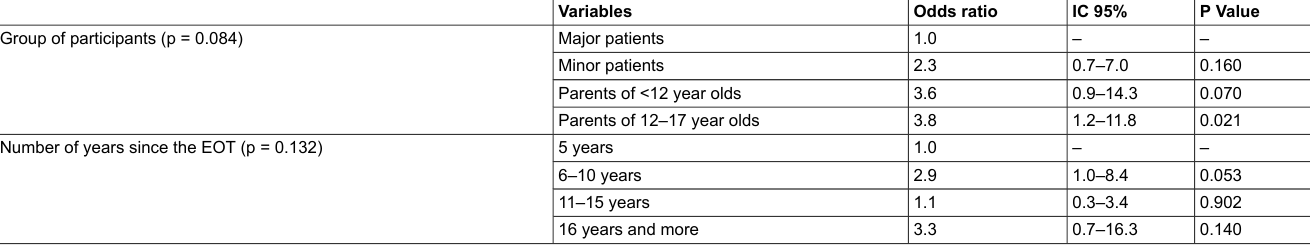
Table S5: Self-assessment of health status.